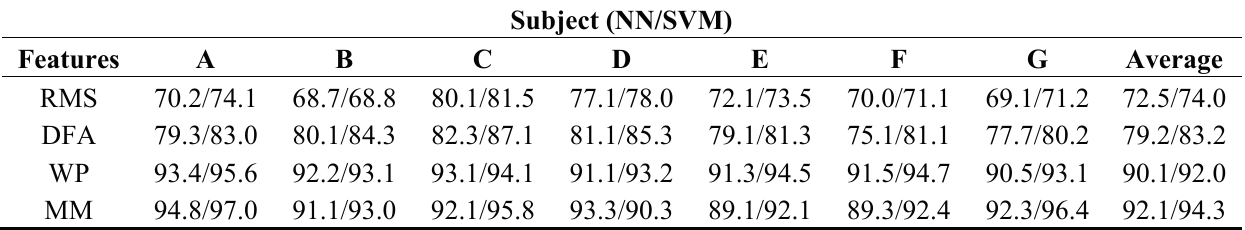
Table 3. Performance of on-line testing. The value is the recognition accuracy rate defined by number of corrected recognized results dividing total results, with unit of %.